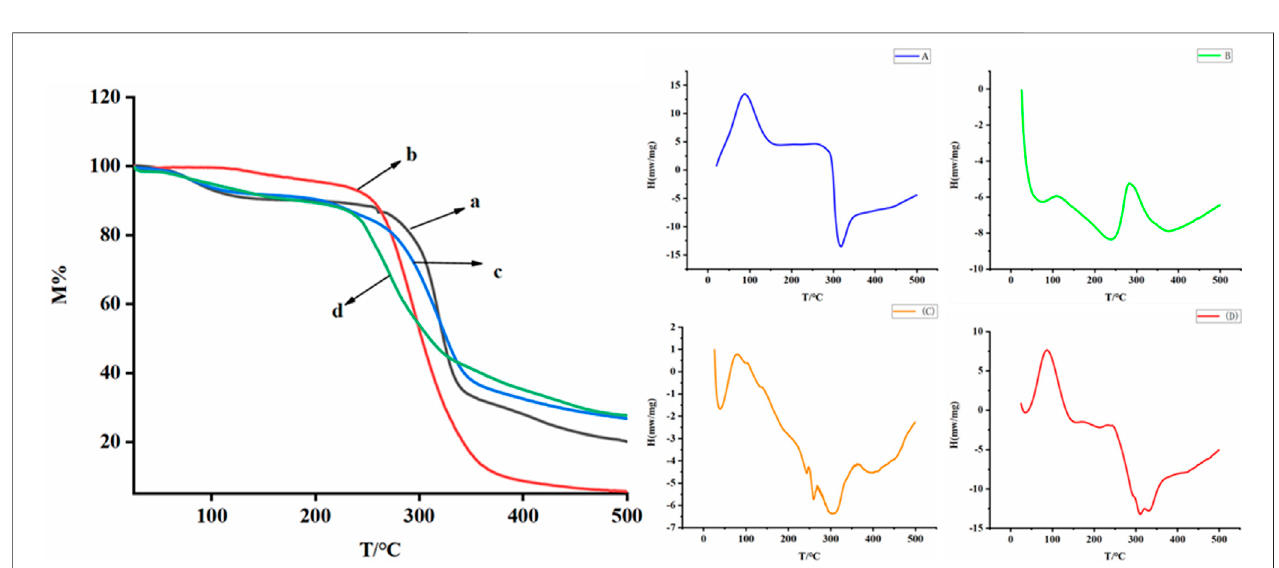
FIGURE 6 | TG curves of (A) BIO-CD, (B) AD-CBD, (C) the physical mixture (AD-CBD: BIO-CD (cid:1) 1:1); (D) AD-CBD/BIO-CD inclusion complex and DSC thermograms of (A) BIO-CD, (B) CBD, (C) their 1:1 physical mixture and (D) inclusion